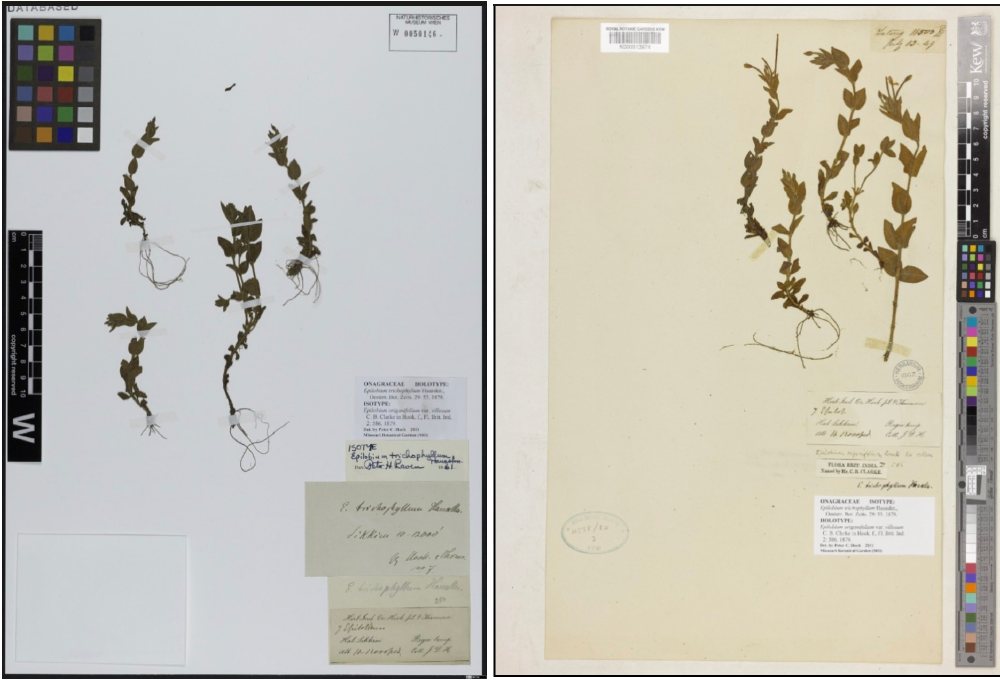
Image 2. The holotype and isotype of Epilobium trichophyllum